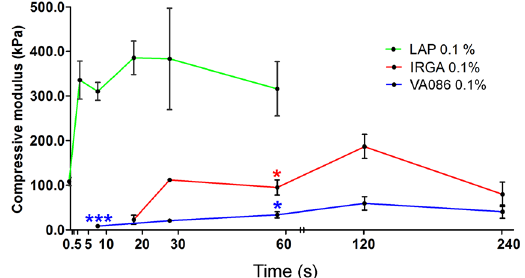
Figure 1. The LAP photo-initiator is able to generate crosslinked hydrogels with the highest modulus values at shortest exposure time (10 s). Compressive modulus (kPa) relative to mechanical properties of GelMa/HAMa, where crosslinking was obtained with three different PIs: Lithium-acylphosphinate (LAP); IRGACURE2959 (IRGA), and VA086 with different photocuring times. The moduli reached by LAP dependent crosslinking are several fold higher respect to the other PIs tested. IRGACURE2959 and VA086 do not achieve the moduli of LAP, even with longer exposure times. Error bars represent standard error of the mean between three replicates. The calculated statistical significance (p < 0.05) was obtained by unpaired t